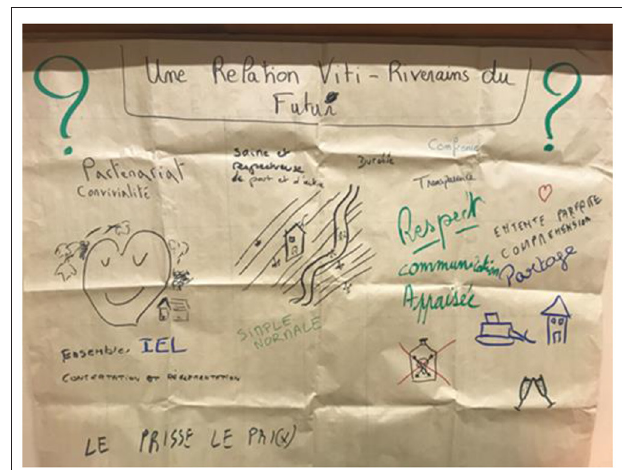
FIGURE 3 | Instant vision during the transformation lab portraying the future relationship between wine producers and local